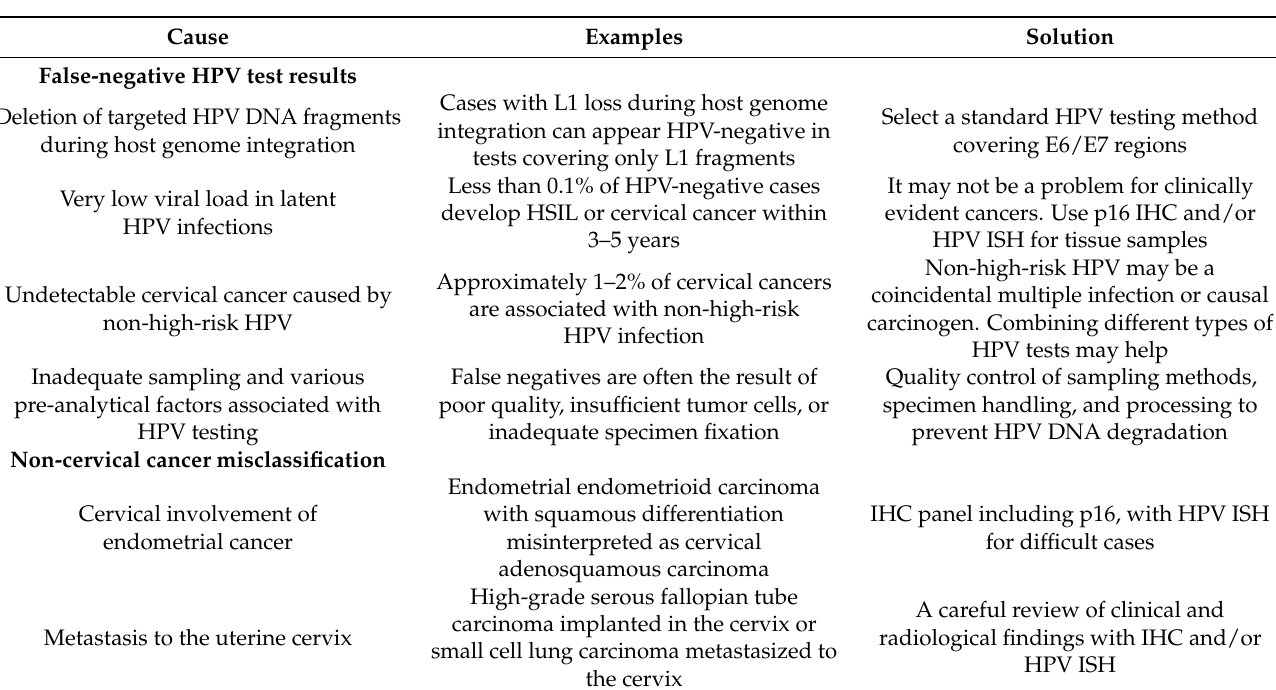
Table 1. Possible causes of false-negative HPV test results and non-cervical cancer